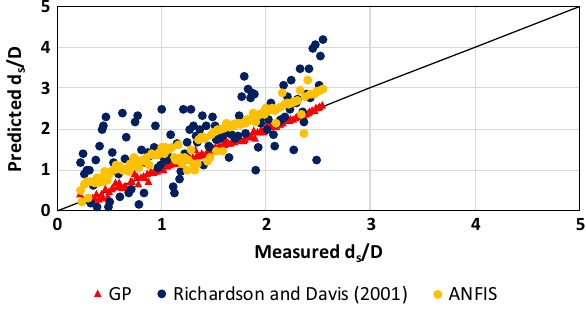
Fig. 7 ANFIS- and GP-predicted values of d cher (1979) values